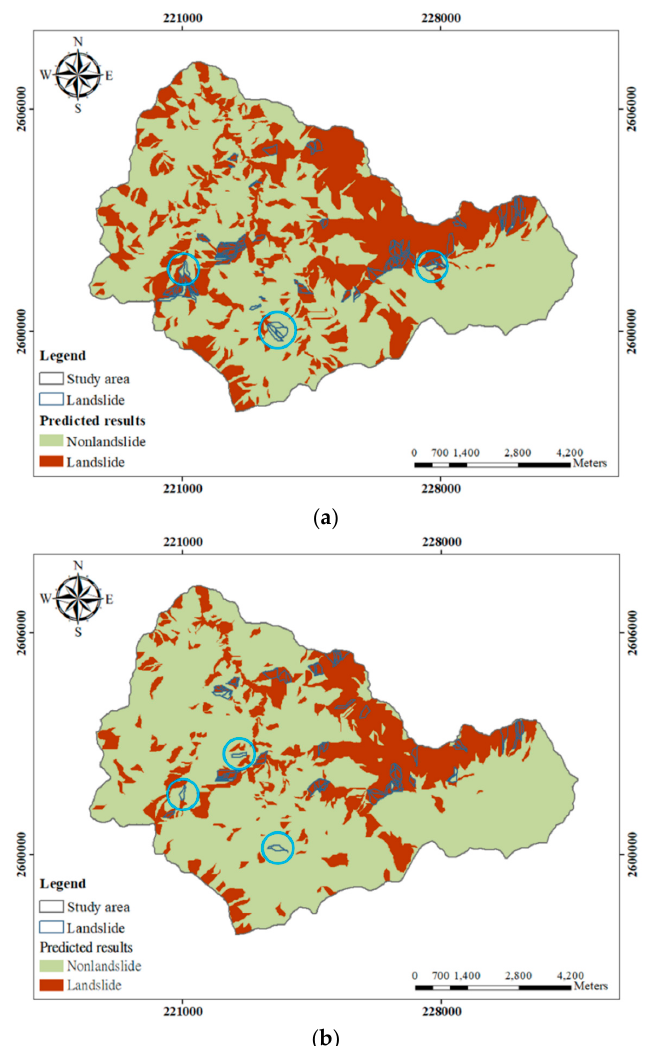
Figure 8. Resultant maps of landslides triggered by typhoon rainfall: ( a ) T = 24 h at Typhoon Talim and ( b ) T = 20 h at Typhoon Jangmi.